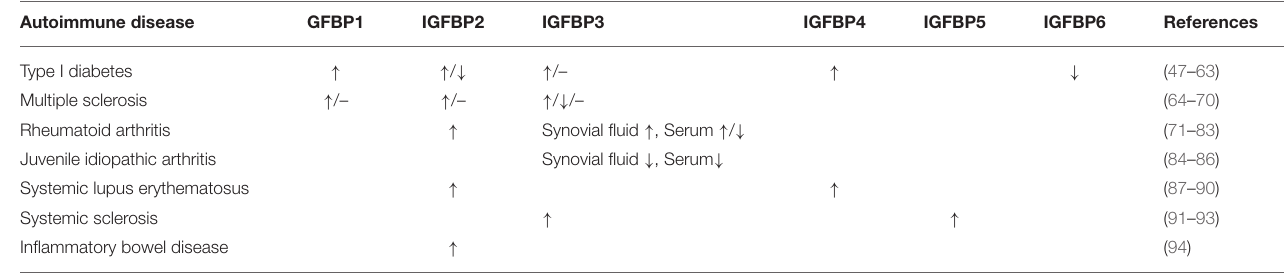
TABLE 1 | Summary of IGFBPs as biomarkers in autoimmune